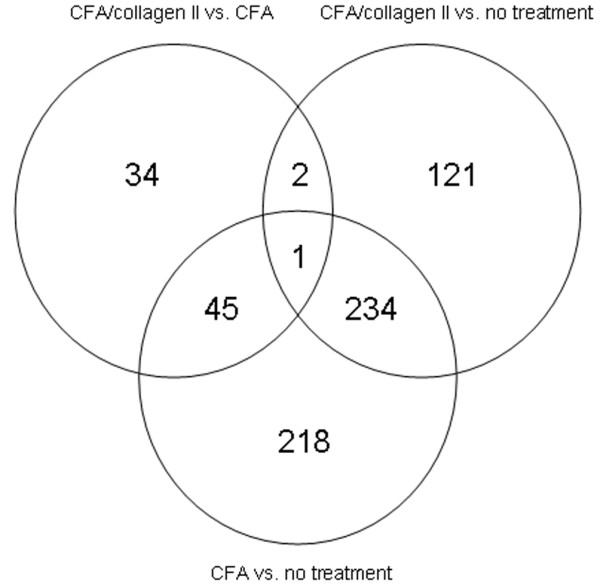
Summary of differentially expressed genes at the early stage of arthritis. Of the approximately 22,000 genes on the Affymetrix chip MOE430a, 655 genes were significantly differentially expressed (minimum 1.5-fold; P < 0.001) in a particular comparison: complete Freund's adjuvant (CFA)/collagen II versus CFA, CFA/collagen II versus no treatment, or CFA versus no treatment. Genes differentially expressed in more than one comparison are shown.